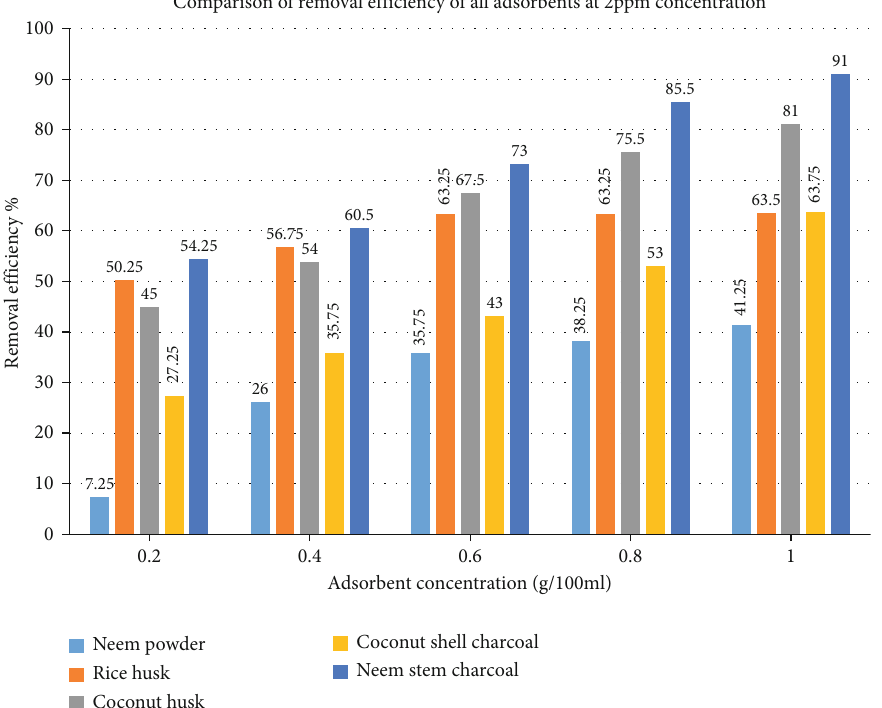
Figure 8: Comparison of removal e ffi ciency of all adsorbents at 4